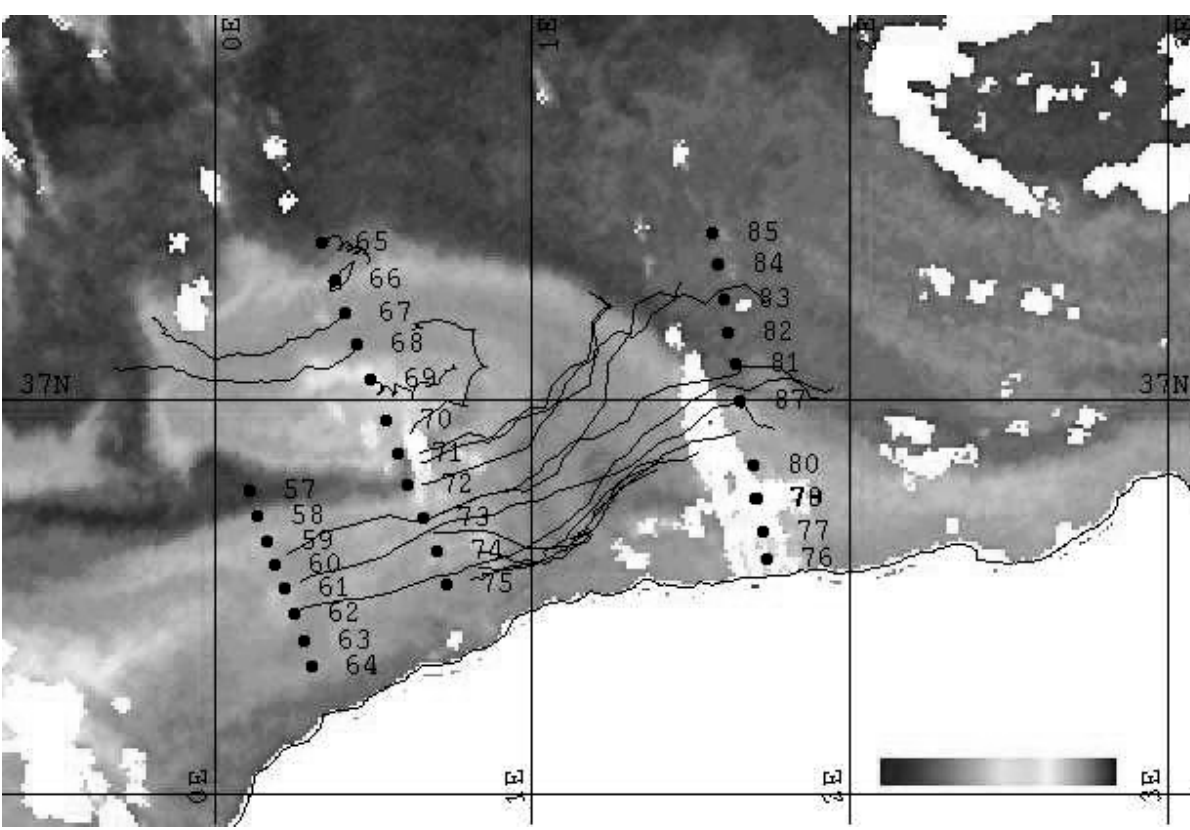
left to drift till the end of their battery life. The fol- lowing day (18 October), the 15 A111 drifters were released at intervals of 5 miles, or 2.5 miles in the core of the current, along a straight line across the (Fig. 1 and Table 1). The shipboard satellite receiv- ing station, when receiving NOAA data, could retrieve the positions of the ARGOS transmitters located by the satellite during each overflight. In this manner, the drifters trajectories were tracked throughout the cruise. After the cruise, a daily on- line access to the ARGOS system was used to derive the complete trajectories of the drifters. The drifters experiment was planned to last 12 months, and the batteries of the instruments (except for the three A104) were sufficient for the platforms to transmit during 400 days. However, they ceased to transmit much more rapidly than expected, in most cases near the coast. We believe the high fail- ure rate in these regions was due to the